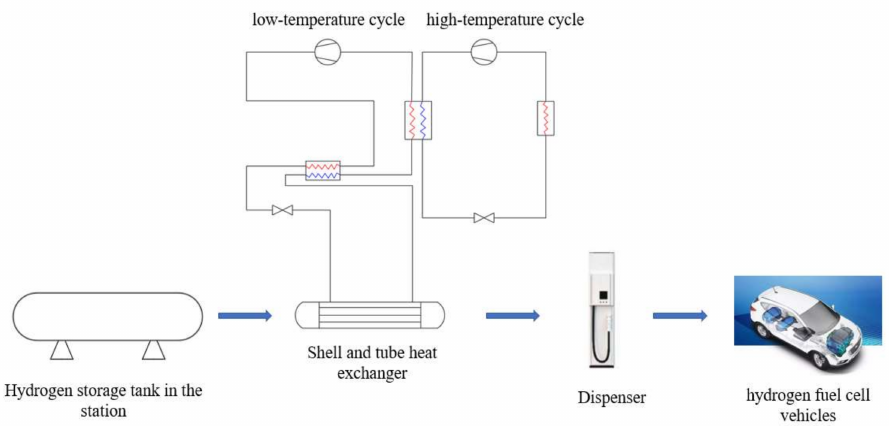
Figure 1. Schematic diagram of hydrogen pre-cooling system in hydrogen refueling station.